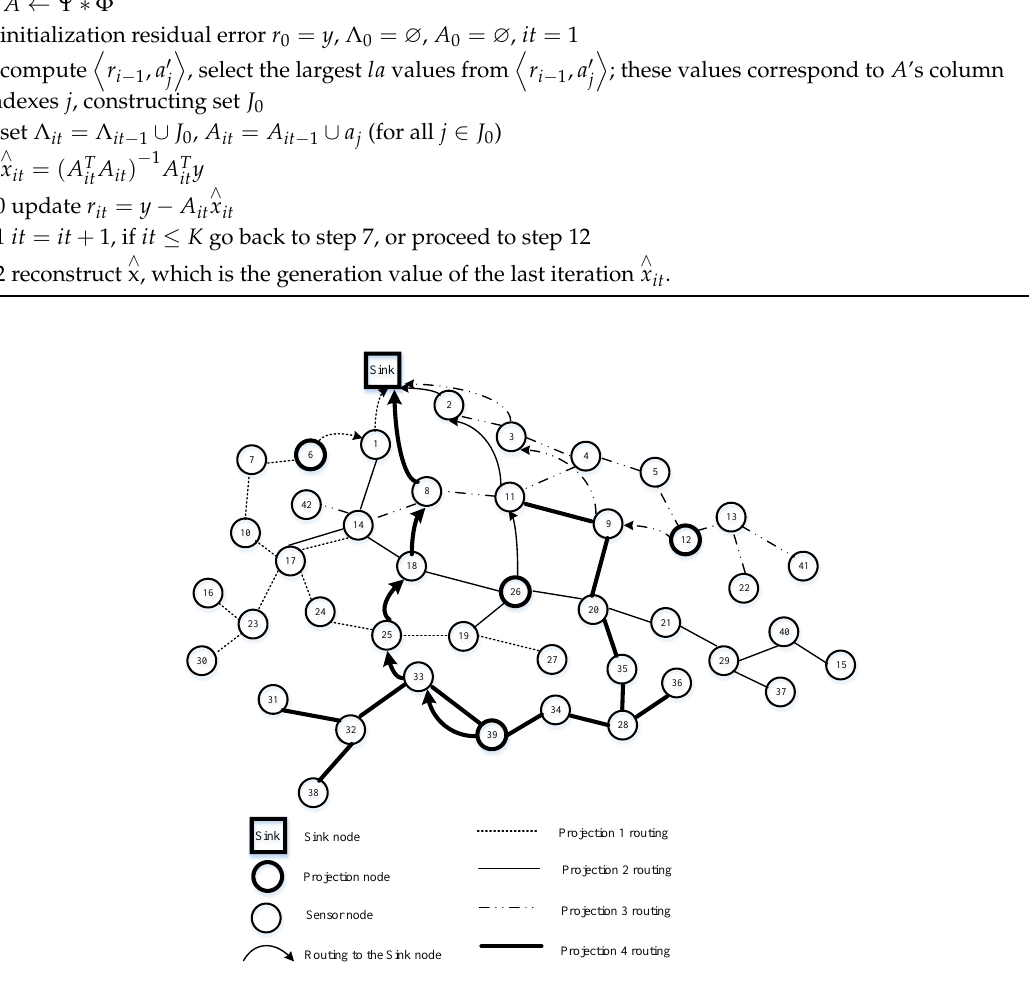
Figure 10. Our proposed algorithm, where N = 42 and M =